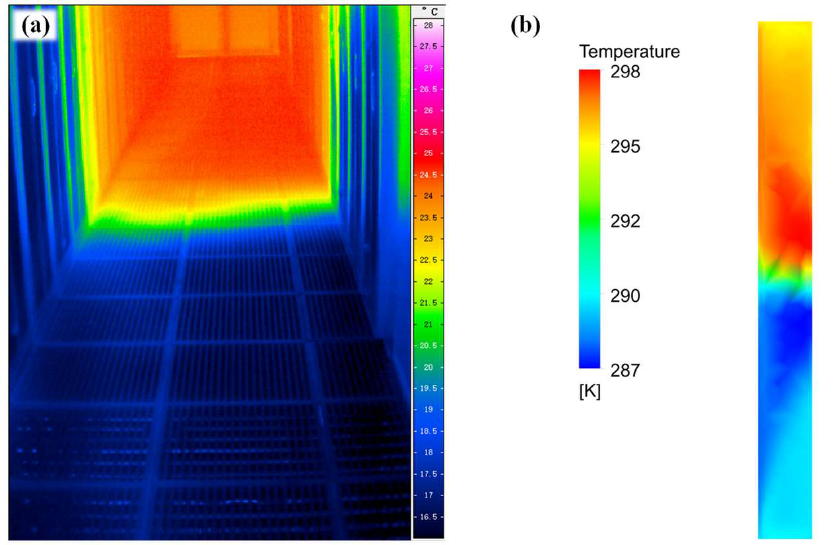
Figure 8. Temperature in the cold aisle: ( a ) infrared camera photos; ( b ) simulation results.